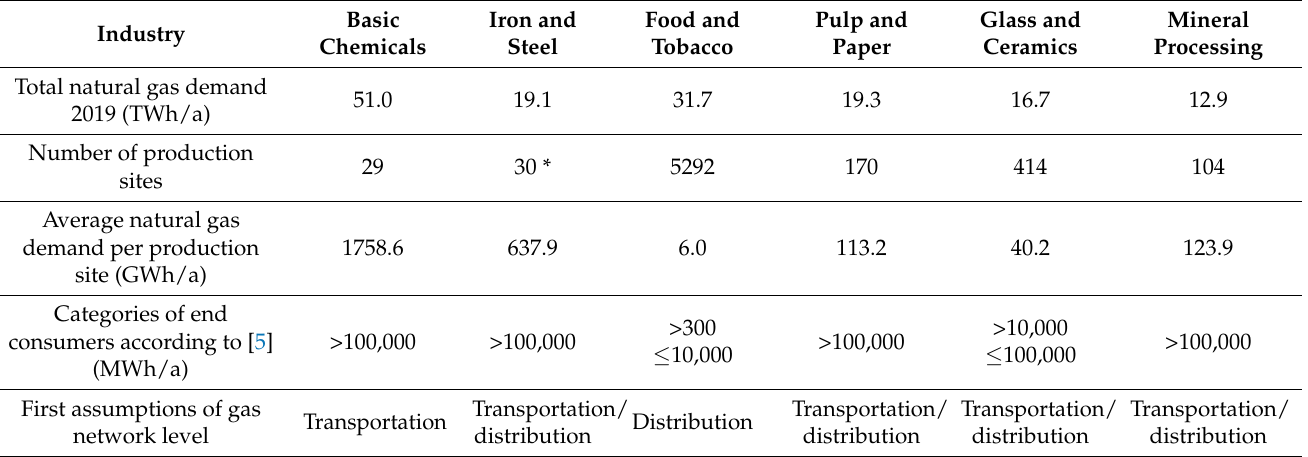
Table 3. Annual natural gas demand of different industries in 2019, their natural gas demand